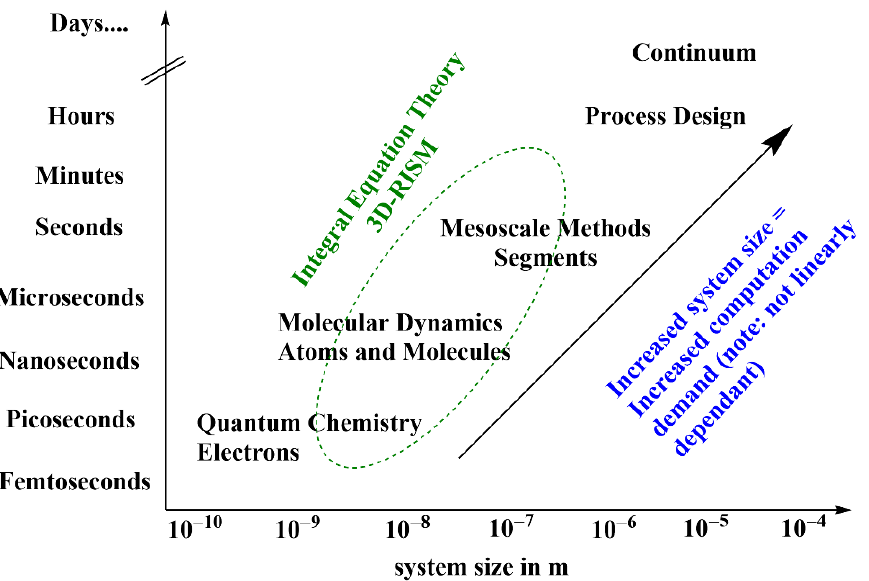
Figure 1. Computational simulation scale and versality of the 3D-RISM theory.